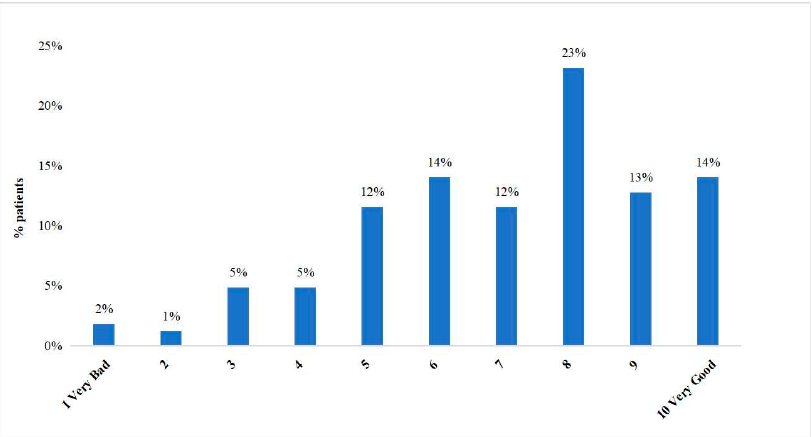
Figure A3. QoL of sample patients ( n = 164). Key: QoL, quality of life.